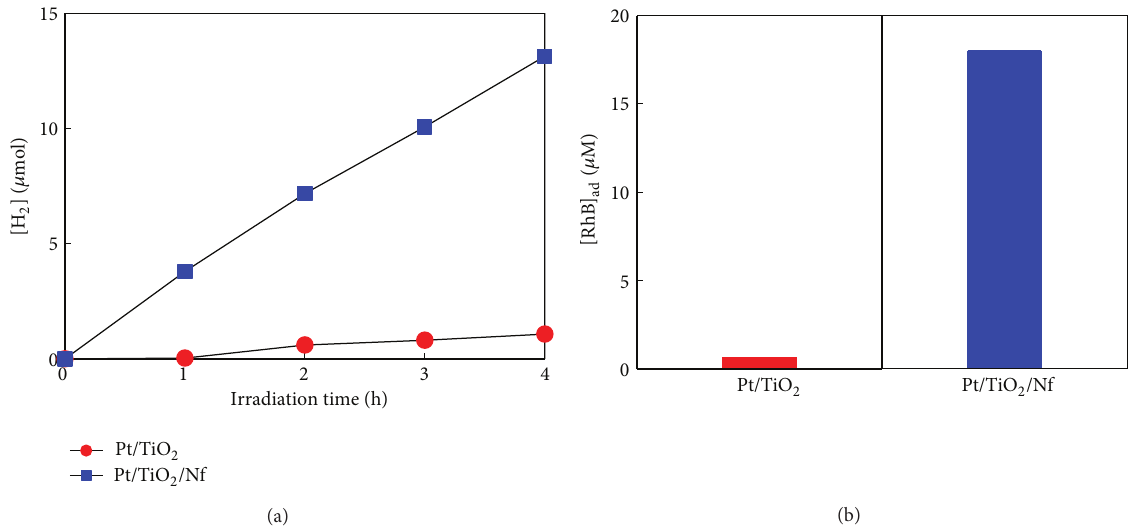
Figure 1: (a) RhB-sensitized H 2 production in the suspension of Pt/TiO 2 and Pt/TiO 2 /Nf. (b) Adsorption of RhB on the surface of Pt/TiO 2 and Pt/TiO 2 /Nf. Experimental conditions: [catalyst] = 0.5 g L −1 , [RhB] = 20 𝜇 M, [EDTA] = 0.4 mM, pH 𝑖 = 5 , and 𝜆 > 420 nm (for part (a)).